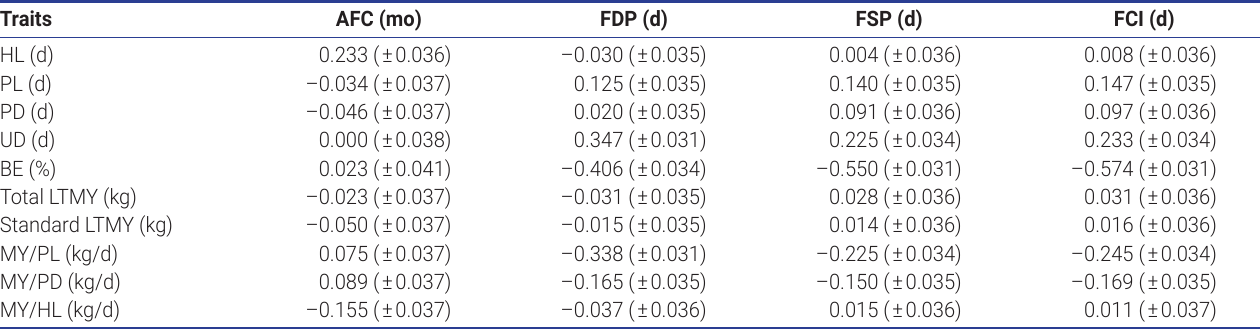
Table 10. Phenotypic correlation between first lactation reproduction and lifetime traits in Murrah buffaloes